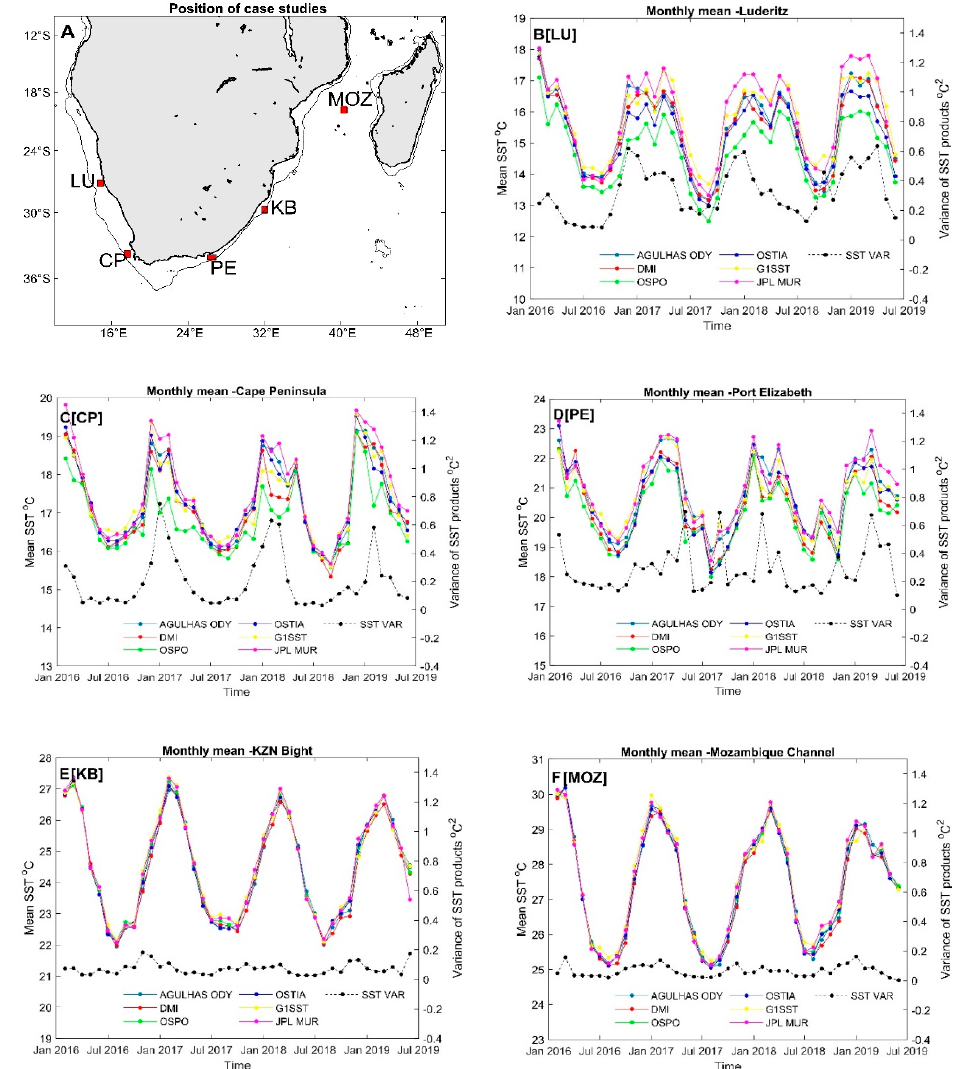
Figure 4. The location of the case study regions is shown in ( A ). The labels LU, CP, PE KB and MOZ in ( B – F ) represent the Lüderitz, Cape Peninsula, Port Elizabeth, KZN Bight and Mozambique Channel, respectively. The thin black contour shows the 1000 m isobath. Line graphs indicate monthly averaged Sea Surface Temperature ( SST ) at the selected case study regions during the 1 January 2016–1 January 2019 period. The variance of the SST products (black line), calculated daily and averaged monthly, is